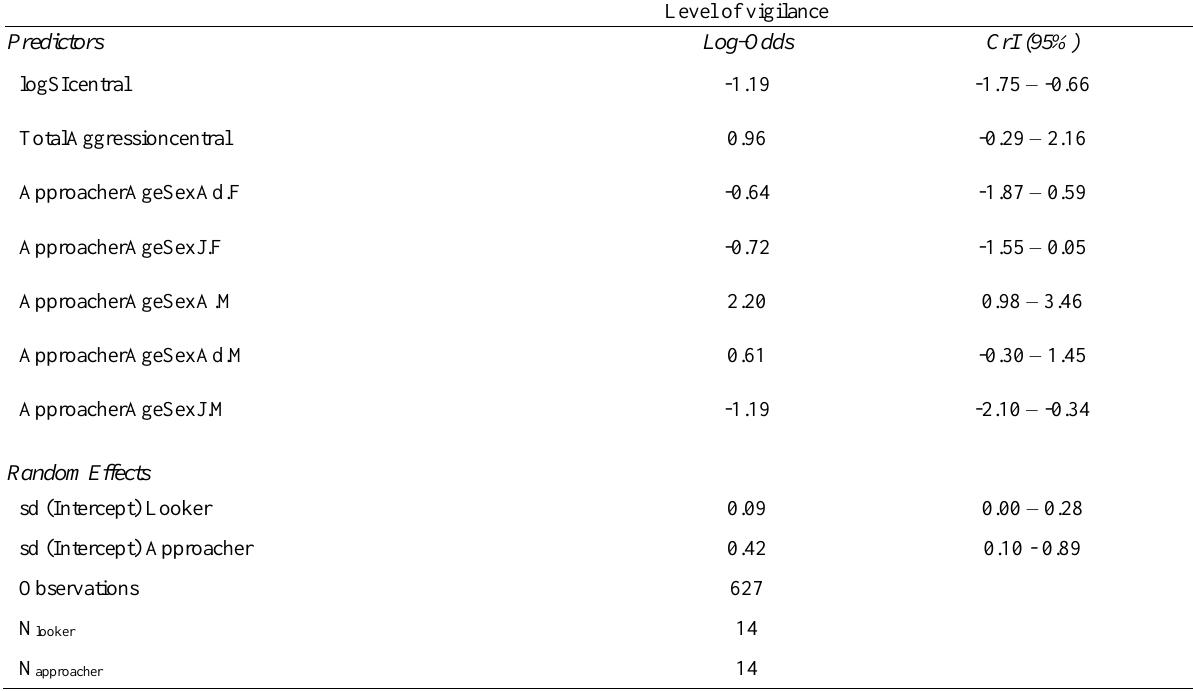
Model Output for the Sequential Model Measuring the Effect of Relationship Quality (Log-Transformed Sociality Index), Rate of Aggression and the Approacher’s Age-Sex Class on the Level of Vigilance from the Approached Focal